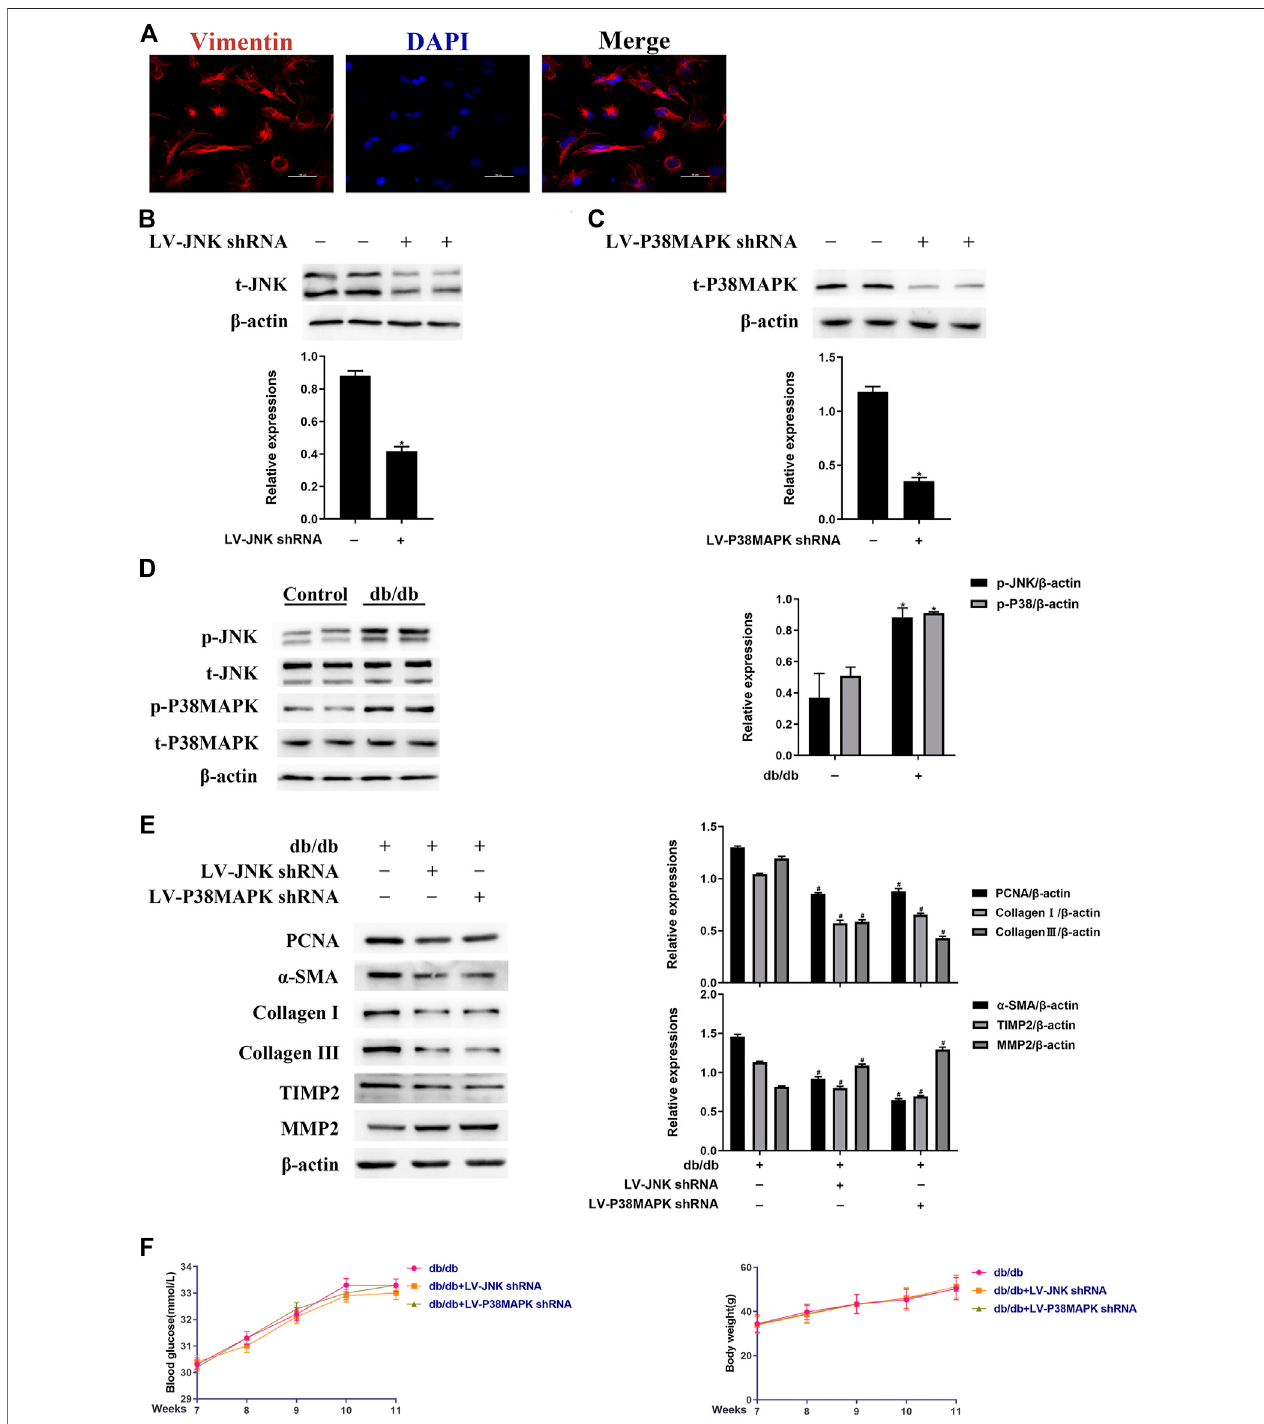
FIGURE 2 | JNK and p38 MAPK mediate the diabetes-induced increase in fi brogenic protein expression in vivo (A) Left ventricular fi broblasts isolated from mice werecon fi rmedbyvimentinstaining.Datawasobtainedfromthreeindependentexperiments (Band C) Isolatedleftventricular fi broblastsfromwild-typemicethatwere orwerenotinjectedwithlentivirusviaatailveinwereevaluatedforJNKandp38MAPKproteinexpressionafter4 weeks (D) Leftventricular fi broblastswereisolatedfrom miceandJNKandp38MAPKphosphorylationandtotalJNKandp38MAPKexpressionweredeterminedbywesternblotting (E) Isolatedleftventricular fi broblasts from diabetic mice that had or had not been injected with lentivirus via a tail vein wereevaluated for PCNA, α -SMA, TIMP2, collagen I, collagen III, and MMP2 expression after4 weeks (F) Between7and11 weeksfollowingthetailveininjectionoflentivirus,thebloodglucoseconcentrationandbodymassofthemiceweremeasured.Data in (B – F) are presented asmean ± SEM ( n (cid:2) 6). p -valuesin (B – D) were calculated using paired Student ’ s t -test. p -valuesin (E-F) werecalculated usingone-wayANOVA with Tukey multiple comparison test. * p < 0.05, compared to the Control group; # p < 0.05, compared to the db/db mice group.